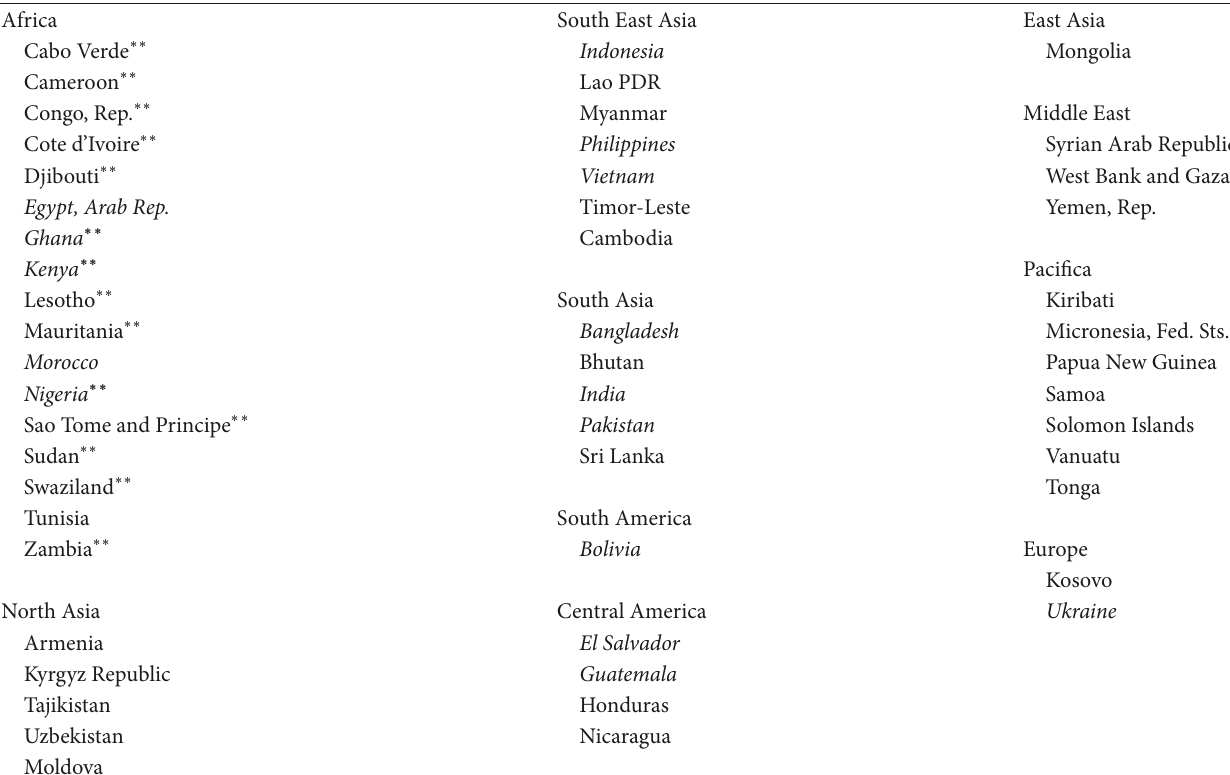
Figure 2: Global cancer statistics regarding the estimated percentage of patients with access to radiotherapy, 2012. Reproduced with permission from Volume 65, Issue 2, pages 87–108, 4 FEB 2015. ∗ refers to countries where 100% of the population can access radiotherapy or countries where radiotherapy is greater in supply than demand, despite possible regional differences in access to radiotherapy within the country. Source: The Cancer Atlas, second edition, as obtained from the International Atomic Energy Agency. Table 1: Lower-middle income economies as defined by the World Bank . LMICsare categorized regionally based upon clinicaltrials.gov regional definitions. Countries written in italic font participate in RCTs in breast cancer research. Countries denoted with ∗∗ are members of Sub- Saharan Africa (US Congress